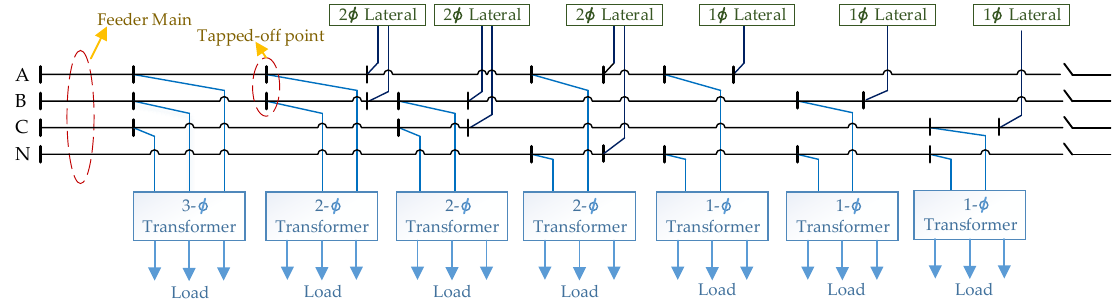
Figure 7. Various connections between the individual distribution transformer and the lateral and tapped-off points in the feeder main.